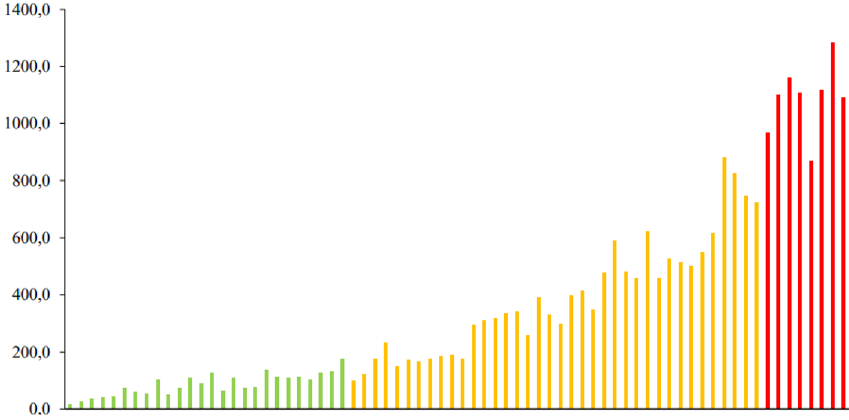
Figure 1. Distribution of 72 ½ Angus × ½ Nellore heifers based on number of eggs per gram of feces (EPG) counts. Green, yellow and red bars means resistant, resilient and susceptible animals, respectively.